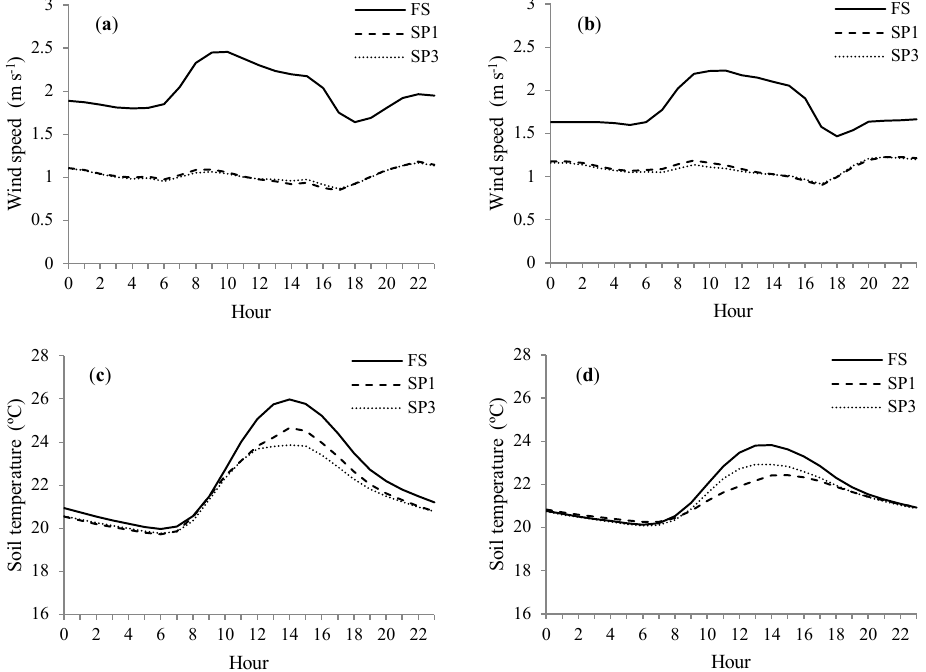
Figure 6. Average wind speed ( a, b ) and soil temperature ( c, d ) in the study years 2 (a, c) and 3 (b, d) at different positions: full sun (FS), below row (SP1), and 7.50 m from the North row